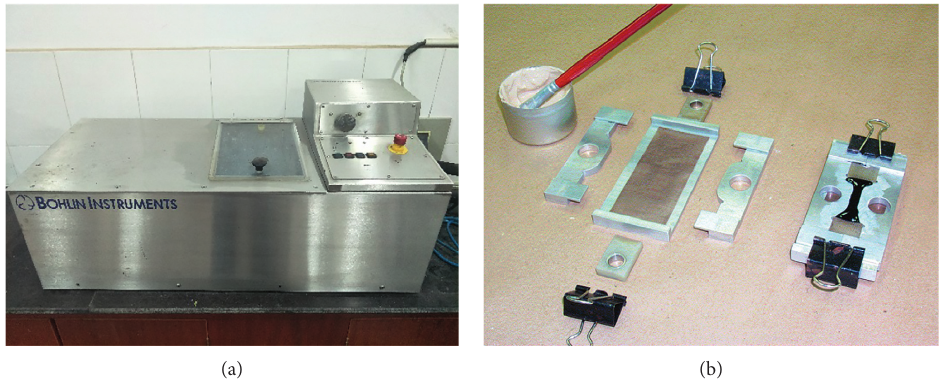
Figure 4: DTT test. (a) DTT equipment (American Interlaken). (b) Test